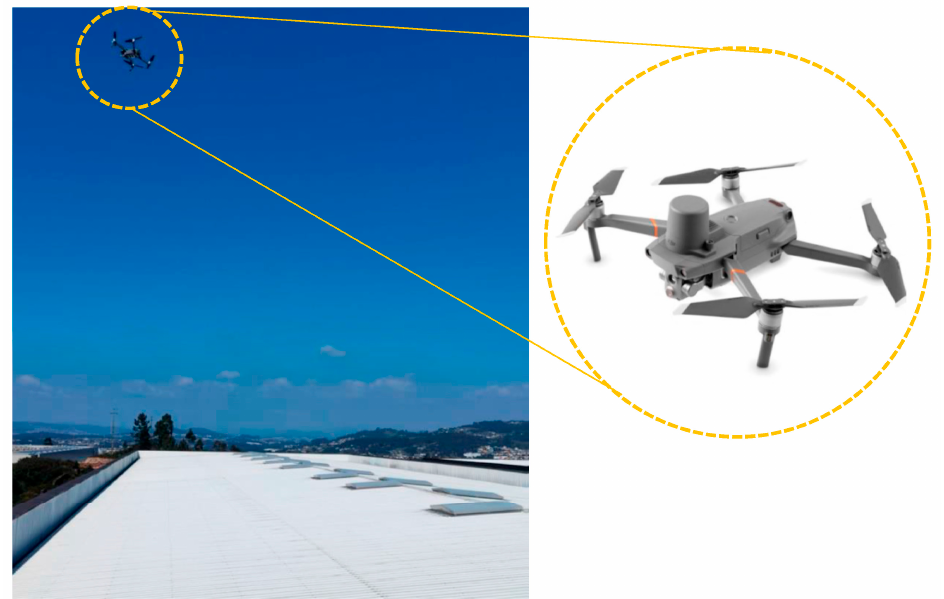
Figure 2. Drone Mavic 2 Enterprise Advanced in